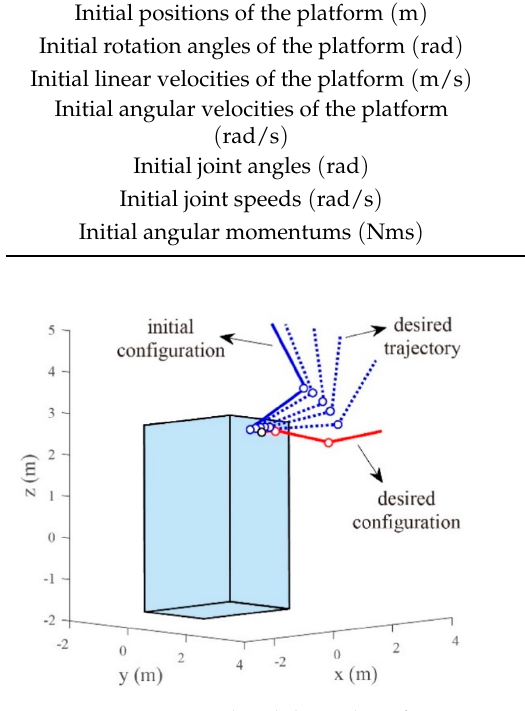
Figure 5. System initial and desired configurations. The controller parameters are listed in Table 4. Table 4. Controller parameters of the system.